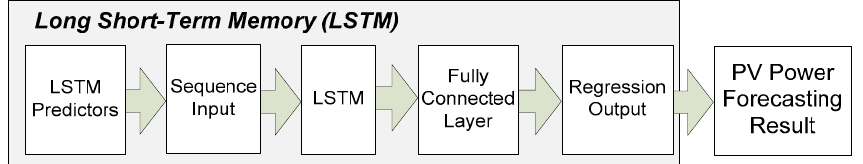
Figure 8. LSTM structure.